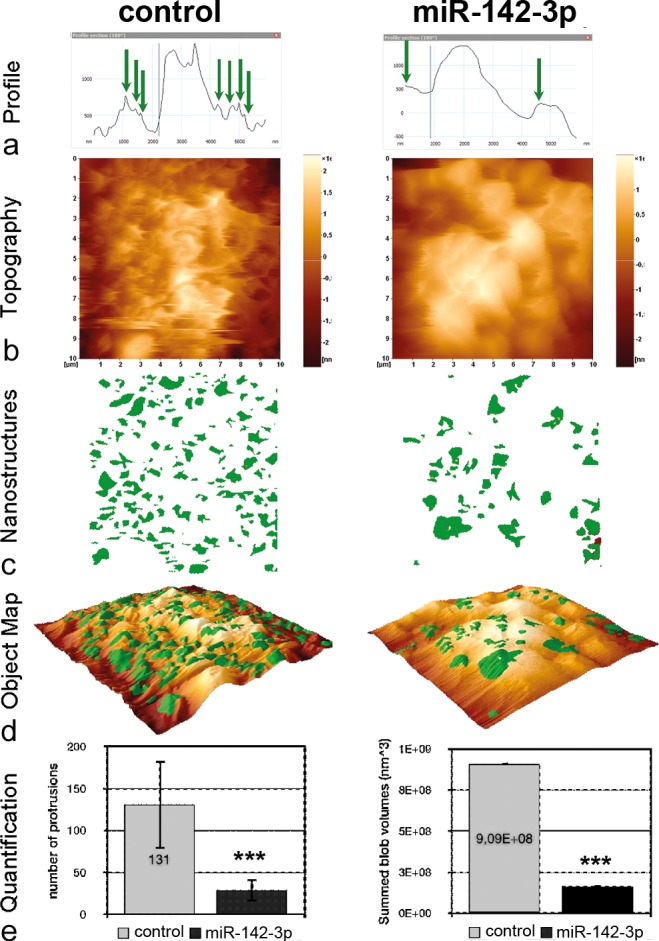
Nano-texture analysis.MDA-MB-468 cell surfaces without (left column) or with treatment by miR-142-3p (right column) were imaged by Atomic Force Microscopy (AFM) at nanometer resolution. Shown are (a) representative height profiles, (b) topography raw data of a (10 μm)2 scan, (c) protruding structure elements (green), (d) the overlay of (a) and (b) in a 3D-map and (e) the number values for the object count and the total volume (given as the sum of individual sizes (LDVs, local deviational volumes) per image). Shown are the mean values ± SD per image for n = 5, ***P<0.001.